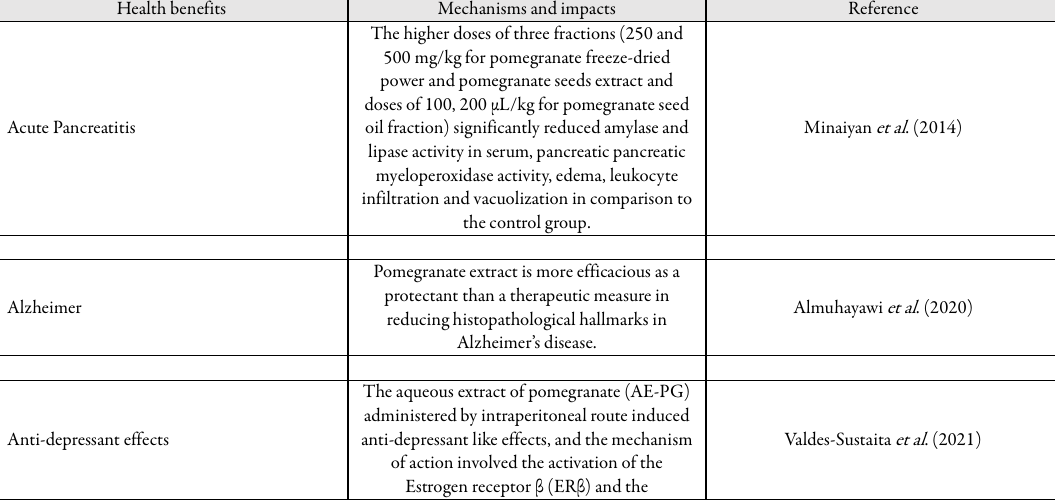
Table 7. Pharmaceutical benefits of pomegranate Health